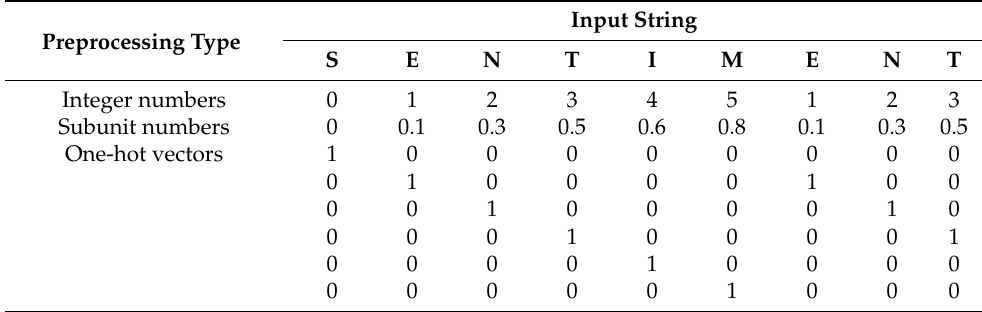
Table 1. Preprocessing results for an example containing the input text “SENTIMENT”.